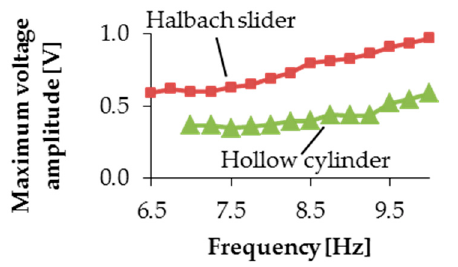
Figure 5. Maximum voltage amplitudes as a function of excitation frequency measured at Halbach slider and hollow